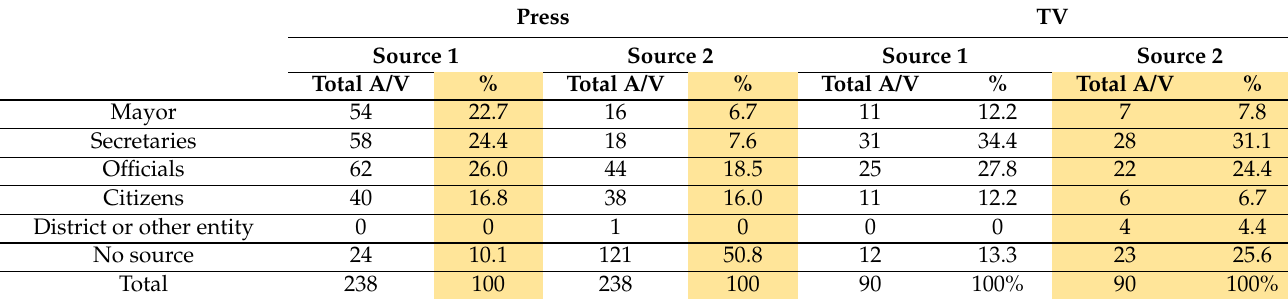
Table 7. Sources 1 and 2 (Source: Authors).